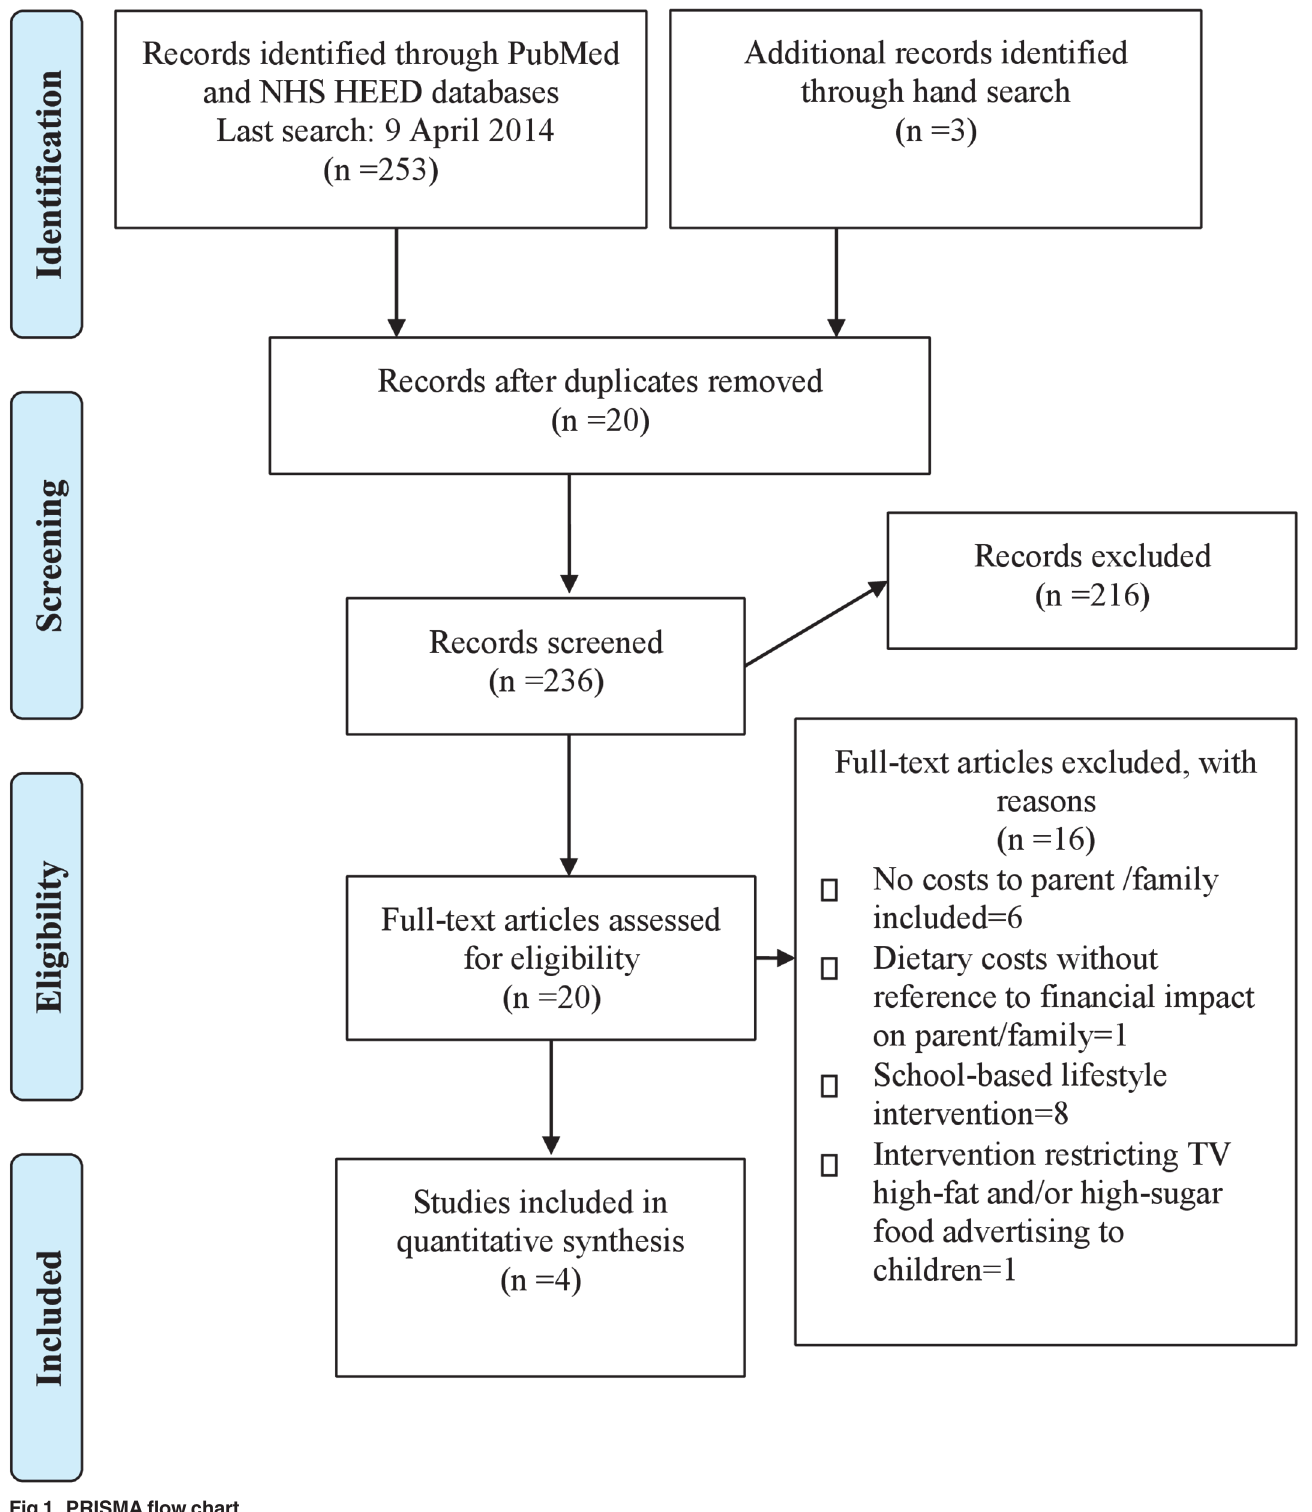
Fig 1. PRISMA flow chart.